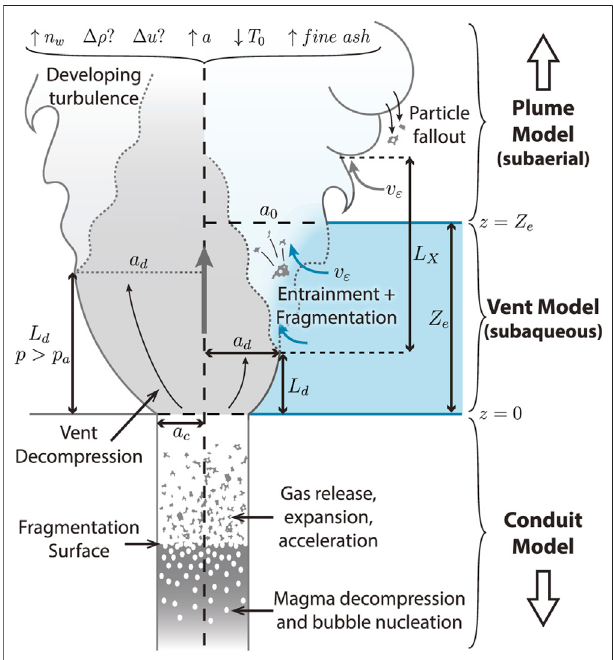
FIGURE 2 | Schematic summary of coupled model, highlighting geometry of the vent and MWI region. The left and right sides are divided between a control scenario with no external water and a scenario with a shallow water layer, respectively. In the hydrovolcanic case, decompression oftheeruptingjetofgasandpyroclastsissuppressedrelative to the dry control scenario (indicated by decompression length L d and radius a d ), and initiation of turbulent mixing with external water results in water entrainment and quench fragmentation. In the water layer scenario shown here,waterdepth Z e isgreaterthanthedecompressionlength L d butlessthan the height at which large entraining eddies are fully developed, L d + L X . See Table1 and Sections2.2 , 2.3 ,and 2.4 foracompletedescriptionofsymbols and